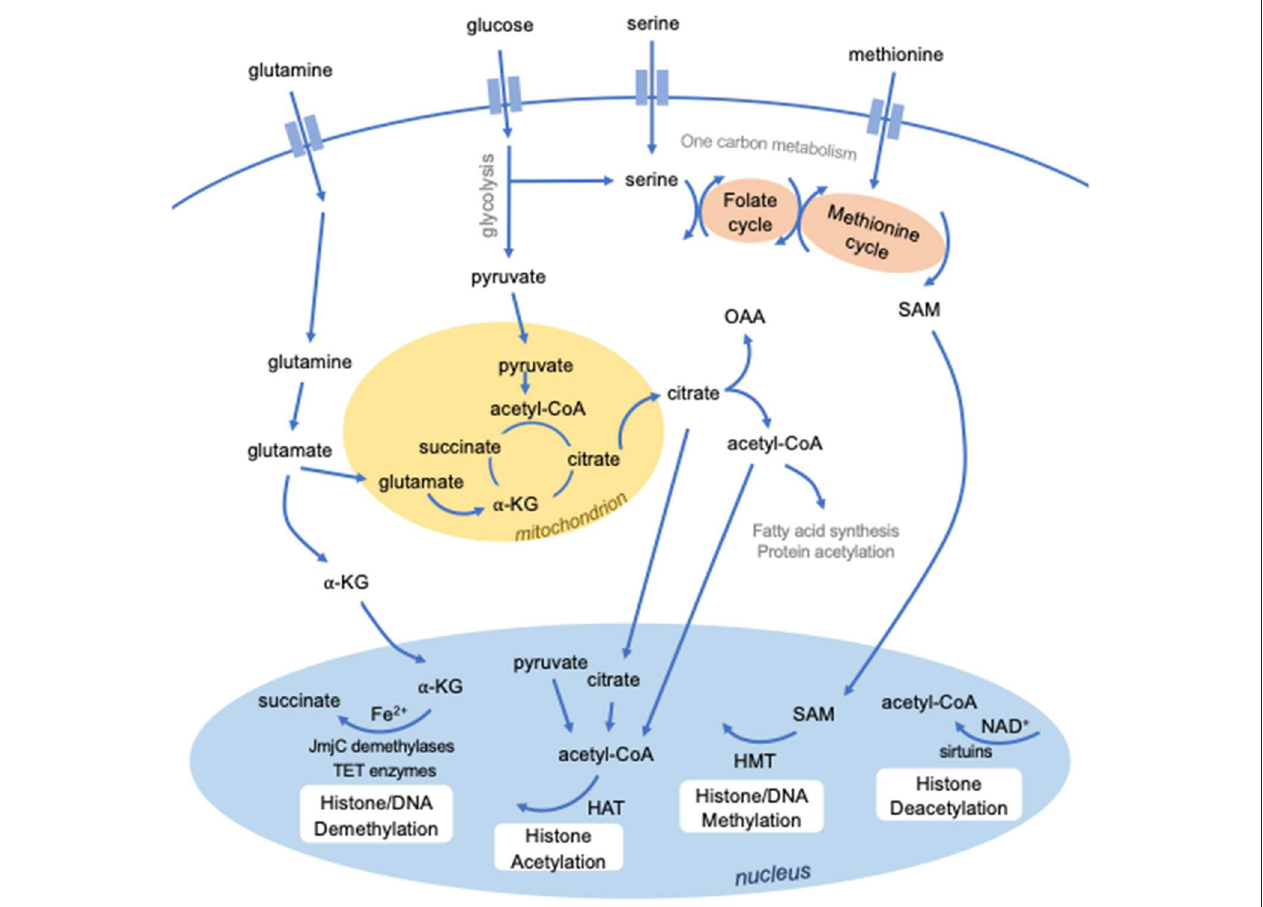
FIGURE 1 | Intersection between metabolism and epigenetics. Several metabolites are required to mediate epigenetic modifications. S-adenosylmethionine (SAM), derived from methionine and one-carbon metabolism, is used for methylation by histone methyltransferases (HMTs). Certain classes of enzymes responsible for histone (JmjC domain-containing demethylases) or DNA (TET enzymes) methylation are dependent on Fe2 + and alpha-ketoglutarate (a-KG). Histone acetylation by histone acetyltransferases requires the metabolic intermediate acetyl-CoA, which can be derived from several sources, including pyruvate, citrate, and